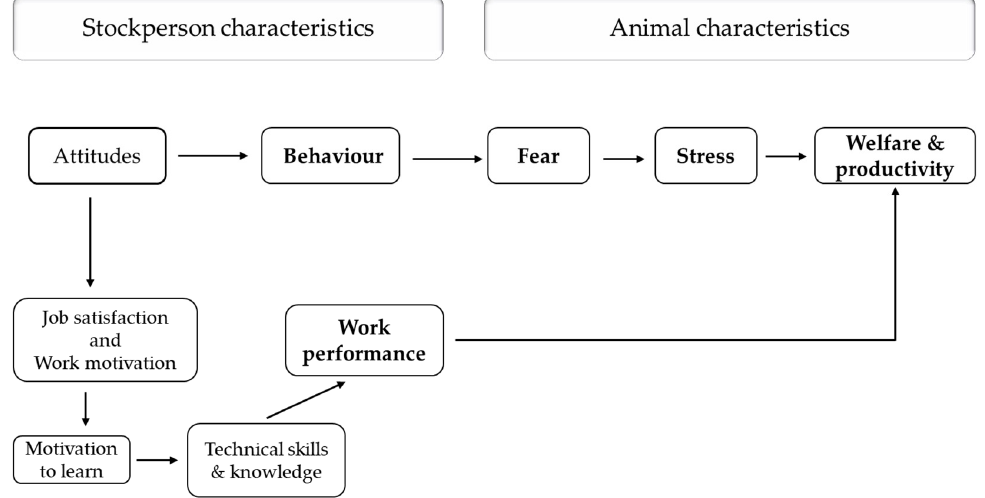
Figure 2. Sequential relationship between stockperson attitudes, behaviour and job-related characteristics and fear, stress, and productivity in farm animals (adapted from [83]).